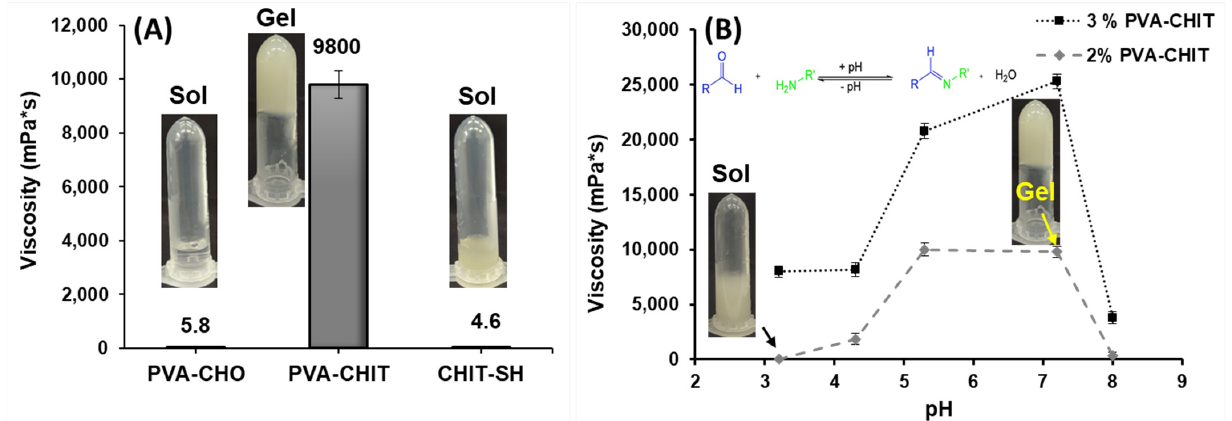
Figure 3. Viscosity measurements of initial polymers (2% w / v ) and prepared hydrogel (2% w / v ) at 37 °C ( A ), and the viscosity measurements of 2 and 3% w / v PVA-CHO/CHIT-SH hydrogels at 37 °C as a function of pH ( B ).